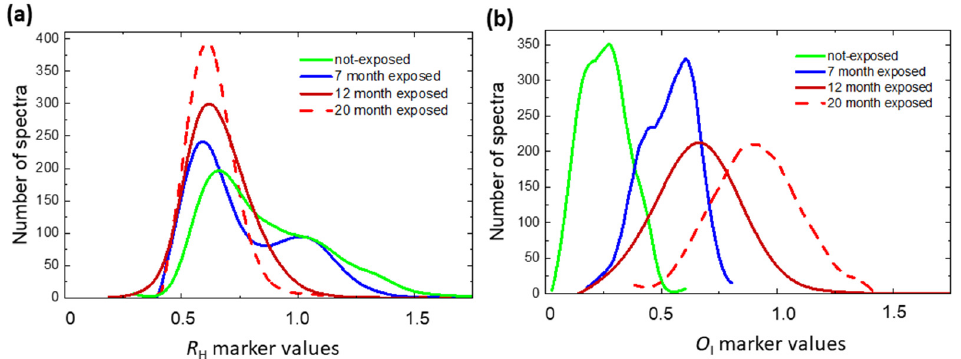
Figure 4. Distributions of ( a ) R H and ( b ) O I values extracted from the maps reported in Figure 3c before and after 7, 12, and 20 months of exposure of paper sample.